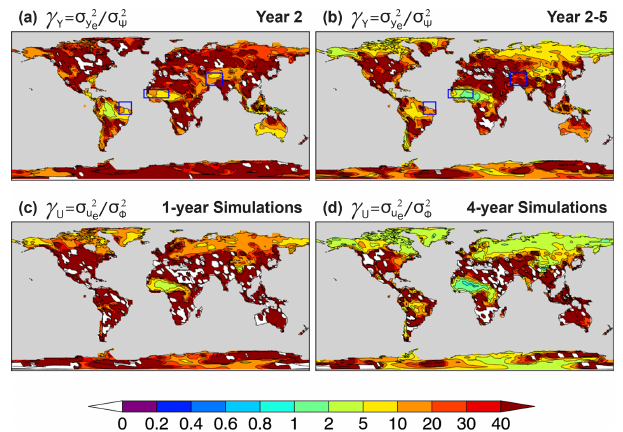
Figure 15. Maps of noise-to-predictable-variance ratio (a, b) γ Y , Eq. (A12), for (a) Year 2 and (b) Year 2–5 hindcasts and (c, d) γ U , Eq. (A13), for (c) 1-year and (d) 4-year averaged uninitialized sim- ulations of annual mean precipitation. The γ Y ratio determines the ensemble size required to average out the noise component from the ensemble mean forecast, Eq. (5), and similarly γ U for simulations. Negative values (white on land) result from sample errors, indicat- ing small ensemble mean variance, and therefore a small predictable signal, relative to the noise variance. The maps are produced with the full 40-member ensembles of hindcasts and uninitialized simu- lations. Rectangular boxes indicate the regions studied in Figs. 16– 18